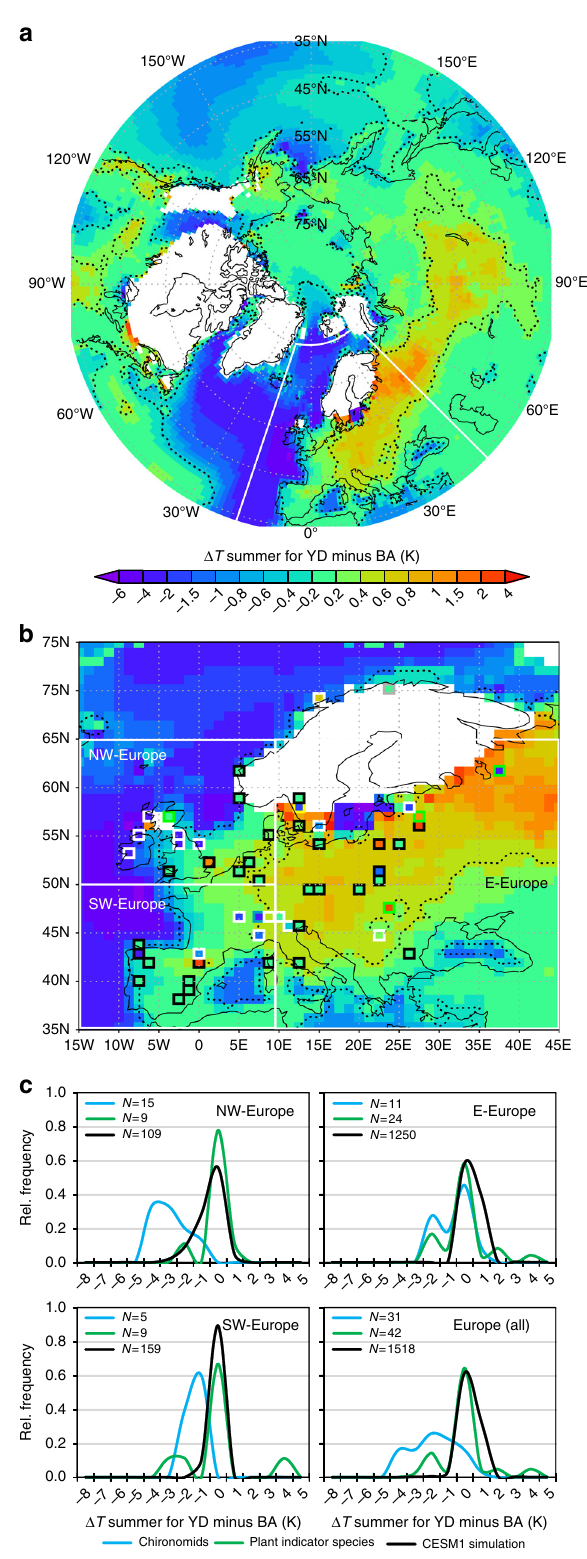
Fig. 2 Summer temperature differences for YD minus BA. a Simulated summer (JJA) temperature differences (K) over the Northern Hemisphere and b over Europe in comparison to multi-proxy July temperature differences based on chironomids (white rectangles), aquatic (black rectangles) and terrestrial (green rectangles) climate indicator-plant species. c Relative spatial frequencies of temperature anomalies (K) across different European regions derived from chironomids (blue), plant indicator species (green) and the CESM1 model simulation (black). Dashed lines in a and b indicate areas with signi fi cant temperature deviations ( p < 0.05). See Supplementary Fig. 1 for a more detailed proxy-type comparison and proxy- based mean